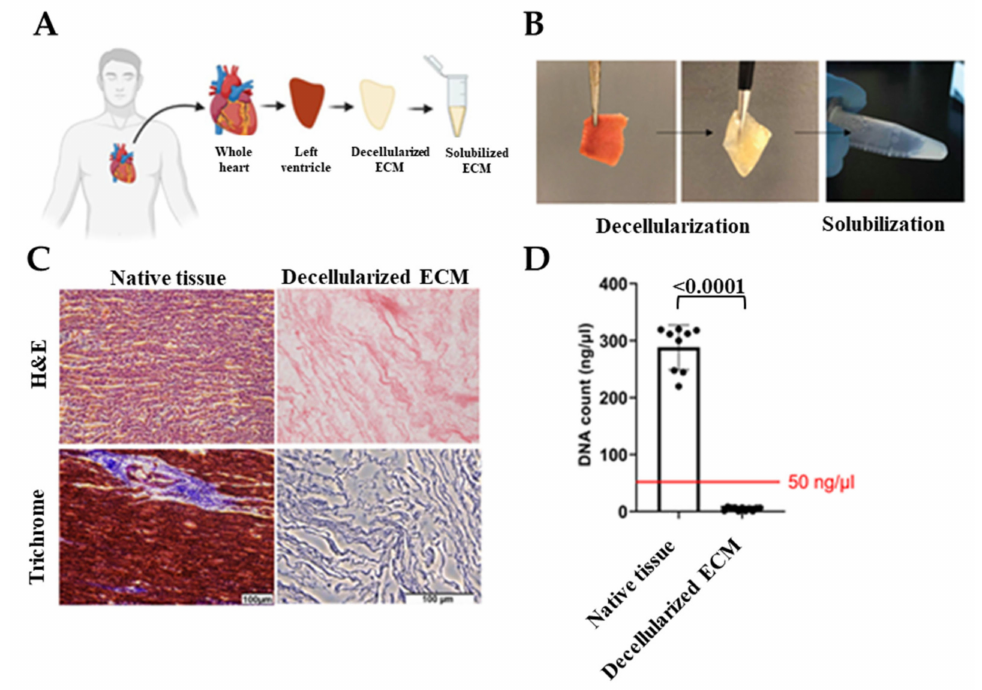
Figure 1. Decellularization of the native tissues and their biochemical analysis. ( A ) Schematic and ( B ) representative images demonstrating the workflow of the decellularization and solubiliza- tion process, ( C ) hematoxylin and eosin (H&E) and Masson’s Trichrome staining of native tissue and dhECM, and ( D ) quantitative measurements of total DNA content of native, decellularized cardiac